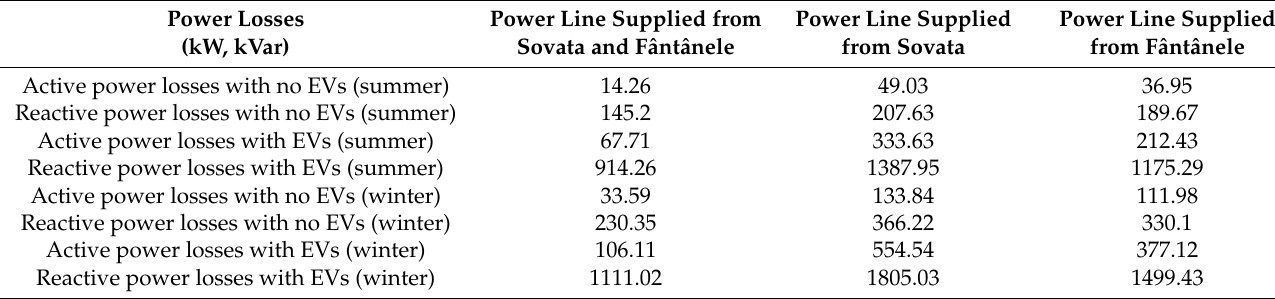
Table 28. Power losses at 18:00 (scenario